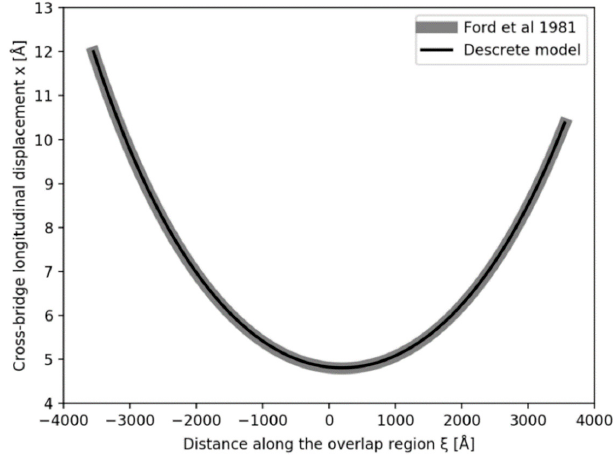
Figure A4. Cross-bridge longitudinal displacement as a function of distance along the overlap region